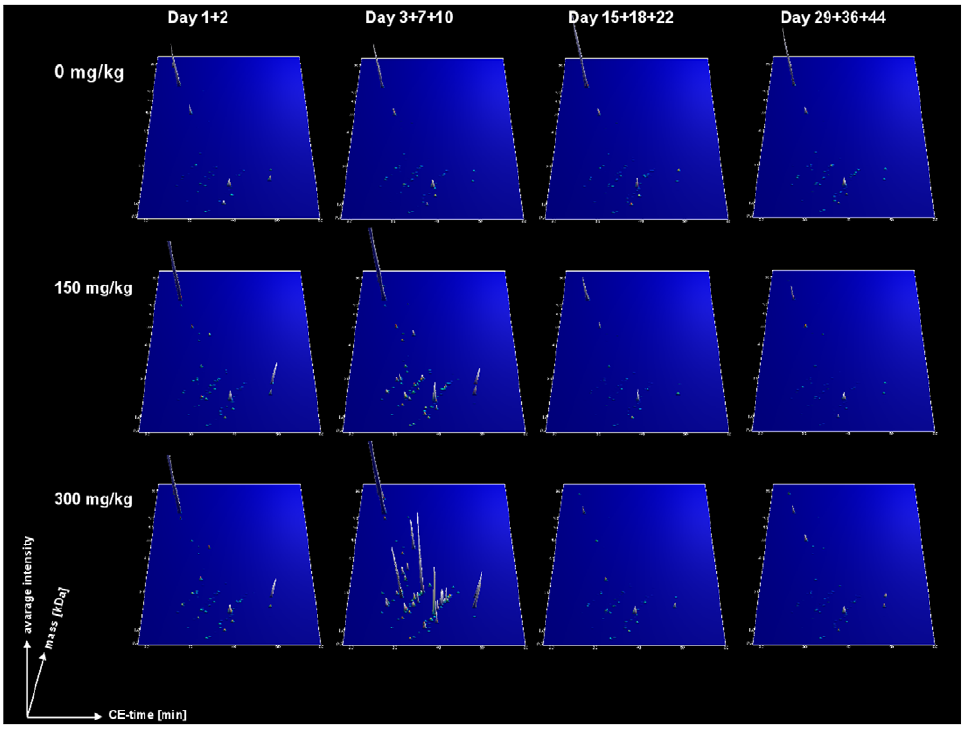
Figure 2. Group specific polypeptide profiles for the 101 drug-induced nephrotoxicity markers in the gentamicin-treated rat cohort. The compiled data sets of urine samples from gentamicin-treated rats at different doses and sampling days are shown. The data sets were divided into four groups according to the days of sampling after initiation of treatment (samples collected at day 1 + 2; day 3 + 7 + 10; day 15 + 18 + 22 and day 29 + 36 + 44 from left to right) and for the gentamicin dose (0, 150 and 300 mg/kg gentamicin from the top to bottom). Molecular mass of the analyzed polypeptides (kDa) in logarithmic scale is plotted against CE migration time (min). The mean signal intensity is represented on the z-axis of the 3D plot.